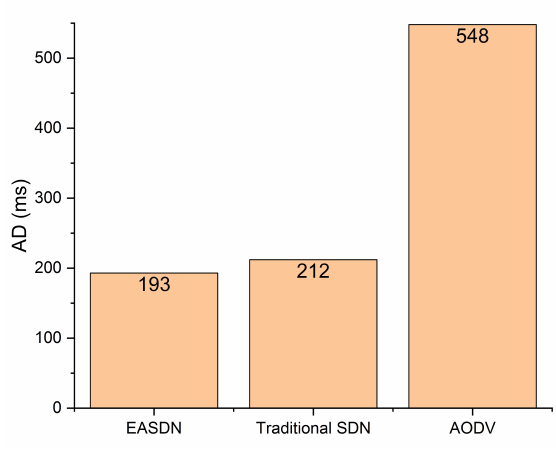
Figure 15. Average delay (30 m × 38